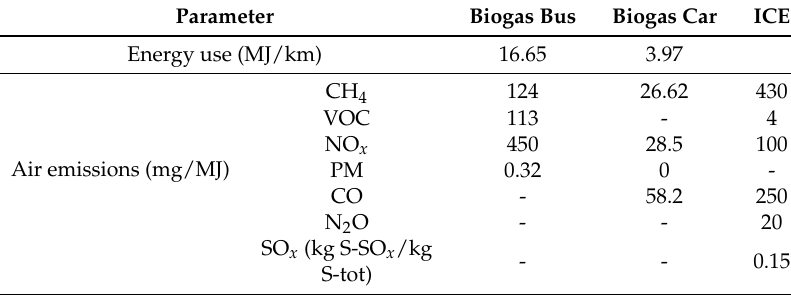
Table A10. Data on biogas utilization. The ICE generates electricity (38%) and heat (52%) with some losses (10%).